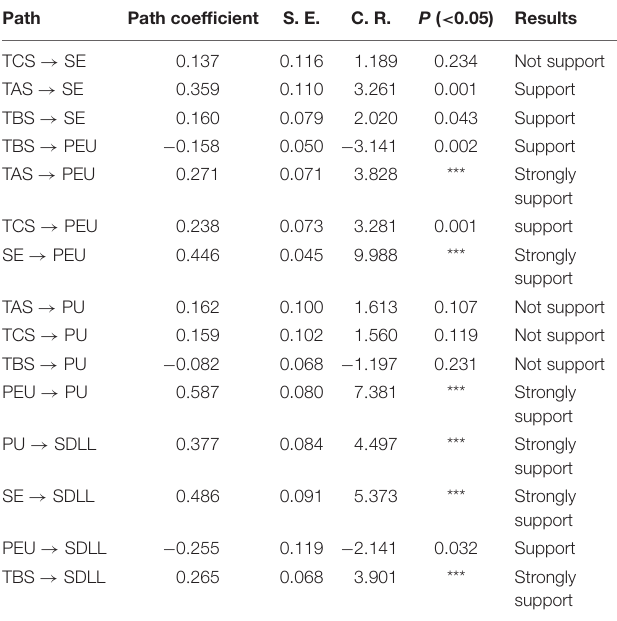
TABLE 5 | The path